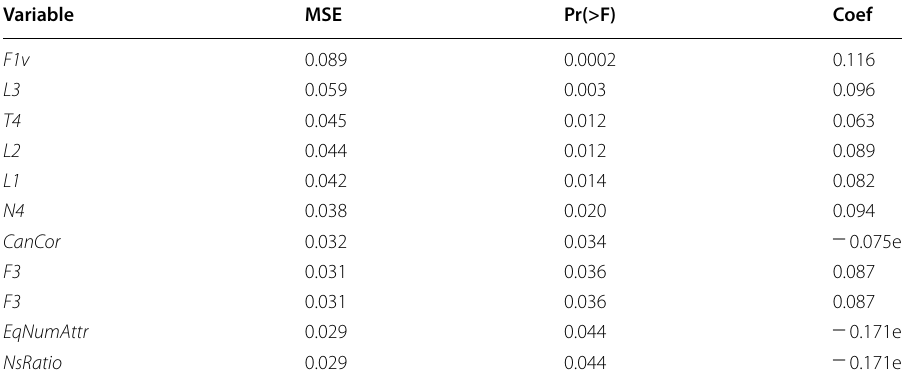
Table 5 The dataset properties that are significant when explaining the cost of comprehensibility using a number of standard dataset properties as independent variables in a regression model where the cost is the dependent